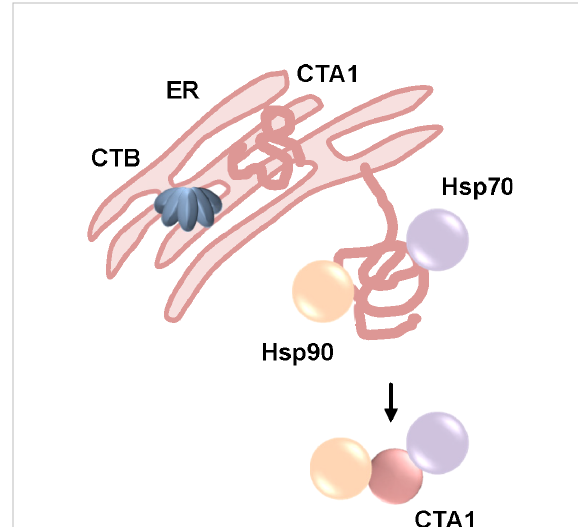
FIGURE 9 The activity of Hsp90, Hsp70 but not Cyps is required to the uptake of CTA1 into cells. After receptor-mediated endocytosis, CT is transported through the Golgi to the ER where CTA1 is released from the B-oligomer (CTB). This leads to unfolding of CTA1 due to thermal instability. Unfolded CTA1 is transported into the cytosol by the ER-associated degradation pathway. Upon inhibition of Hsp90 or Hsp70 intoxication of cells by CT is reduced and less CTA1 is detected in the cytosol (Taylor et al., 2010; Burress et al., 2014; Burress et al., 2019; Kellner et al., 2019; Kellner et al.,